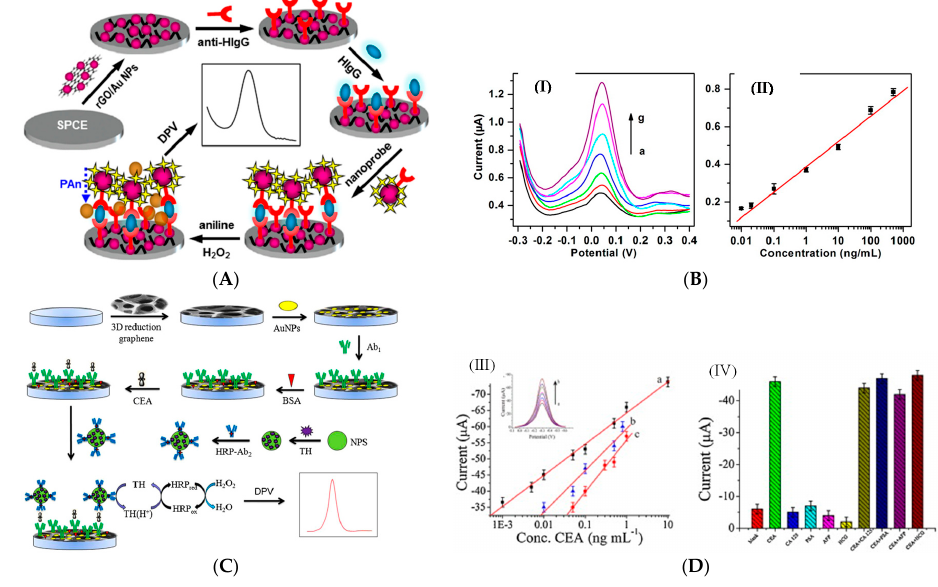
Figure 16. ( A ) Sandwich immunoassay for IgG detection using HRP-AuNP for oxidation of aniline into polyaniline; PANi is detected by DPV. Adapted with permission from [91]. Copyright